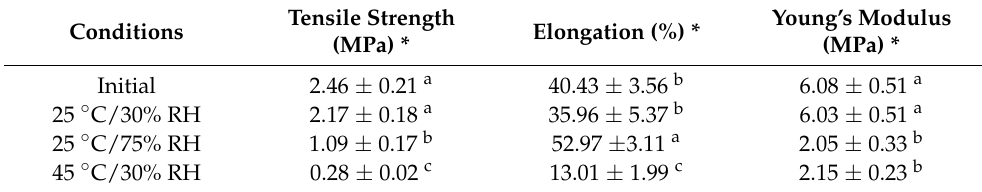
Table 5. Mechanical properties of CP-F at initial measurement and after storage at various conditions for 12